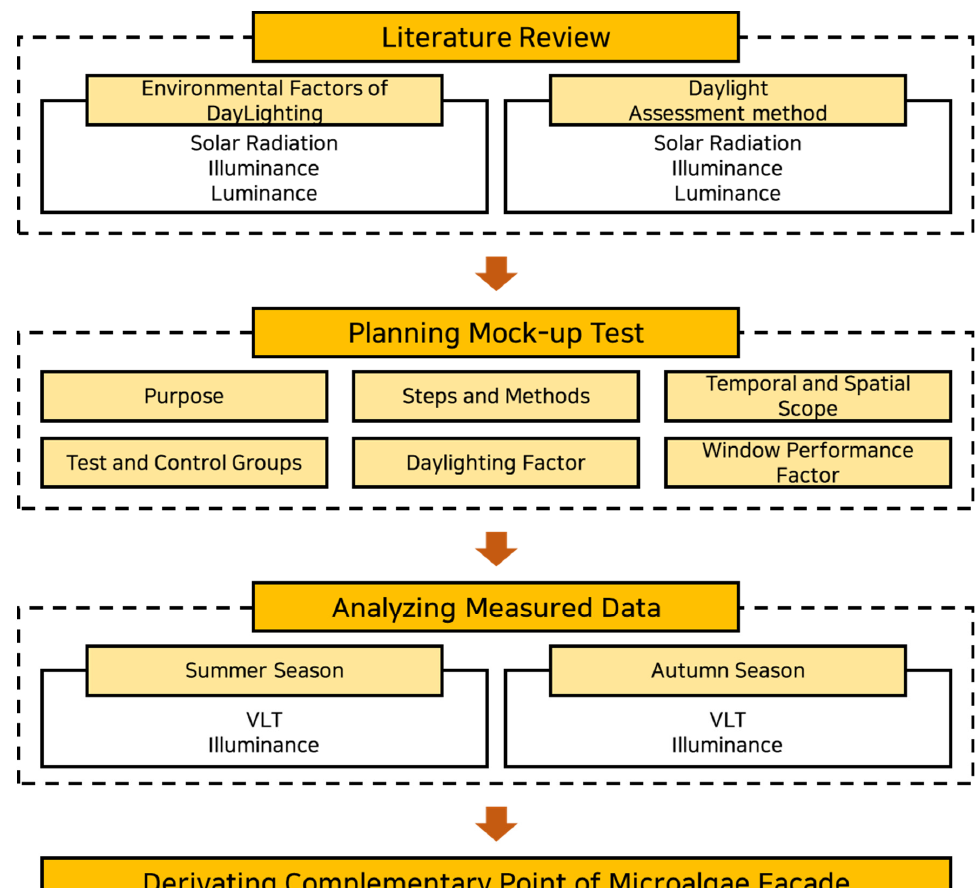
Figure 1. Research flow.